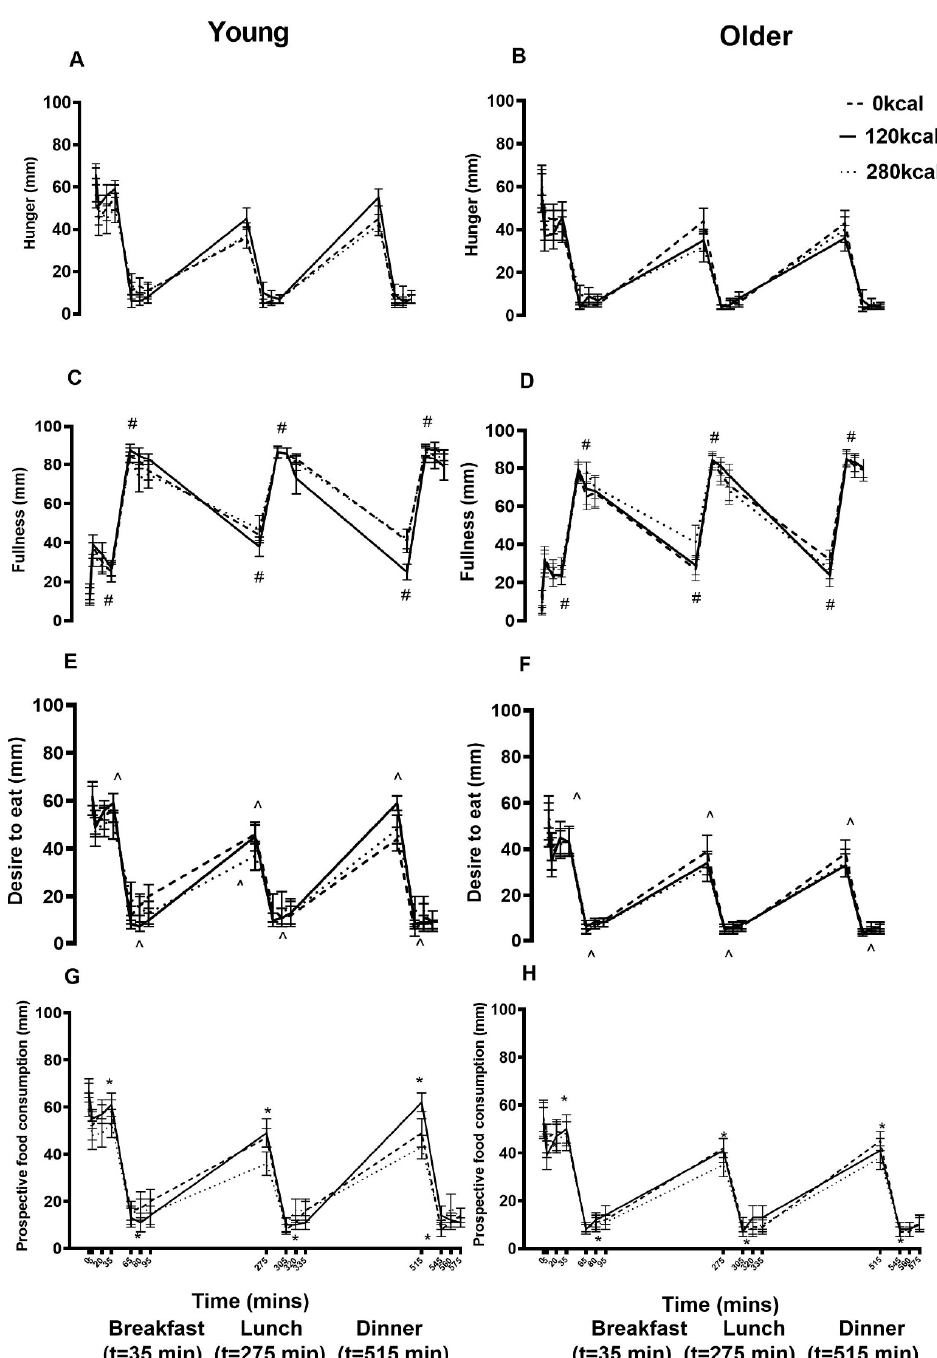
Figure 5. Mean ( ± SEM) visual analogue scores (VAS; 0–545 min) of hunger ( A , B ), fullness ( C , D ), desire to eat ( E , F ), and prospective food consumption ( G , H ) following overnight fasting (t = − 5) and after drink ingestion (t = 0, 5, 20, 35, 65, 80, 95, 275, 305, 320, 335, 515, 545, 560, 575 min) containing flavored water (control, ~2 kcal) or whey protein (30 g / 120 kcal or 70 g / 280 kcal; open bars) and immediately before and after breakfast (B), lunch (L), and dinner (D) in young (left; n = 15) and older (right; n = 15) men. Age and protein load main effects and interaction effects were determined using repeated-measures ANOVA. Protein a ff ected # fullness (protein load main e ff ect P < 0.001), ˆ desire to eat ( P < 0.001), and * prospective food consumption ( P = 0.002) in a protein load related fashion. Older compared to younger men had lower desire to eat (main e ff ect of age P = 0.028) and fullness ( P = 0.003, interaction e ff ect P <